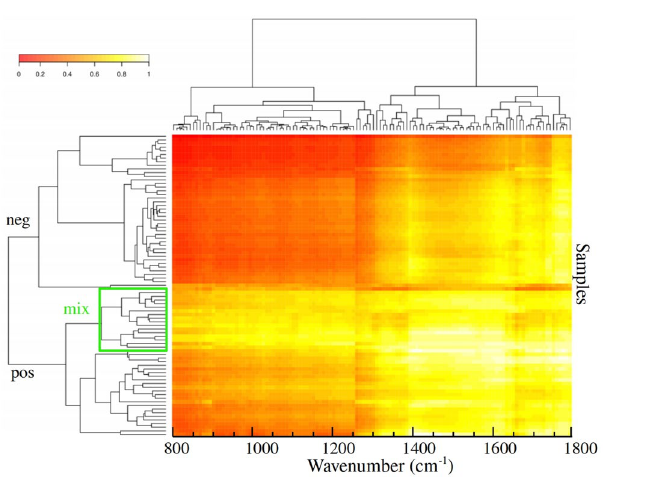
Figure 5. Heatmap for micro-FTIR data. Clustering result shown as a heatmap organized by samples (vertical axis) and wavenumber (horizontal axis). Negative, positive, mix classes grouped into distinct